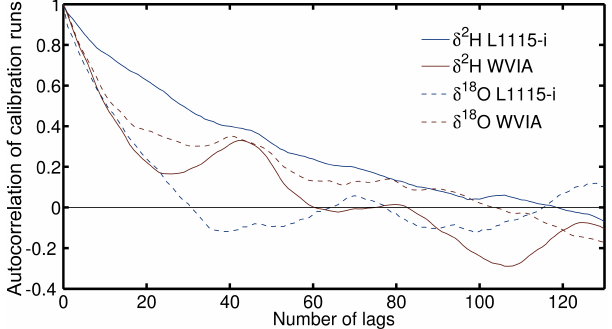
Fig. 9. Autocorrelation function of the isotopic composition of the calibration runs of the long-term stability experiment for L1115-i and WVIA. A lag of 1 corresponds to a 30min calibration